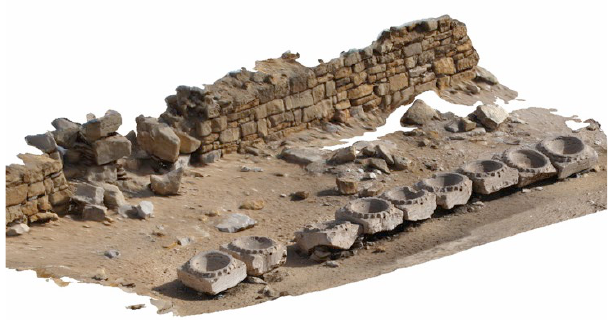
Figure 4: Close-range photogrammetry survey: the area of